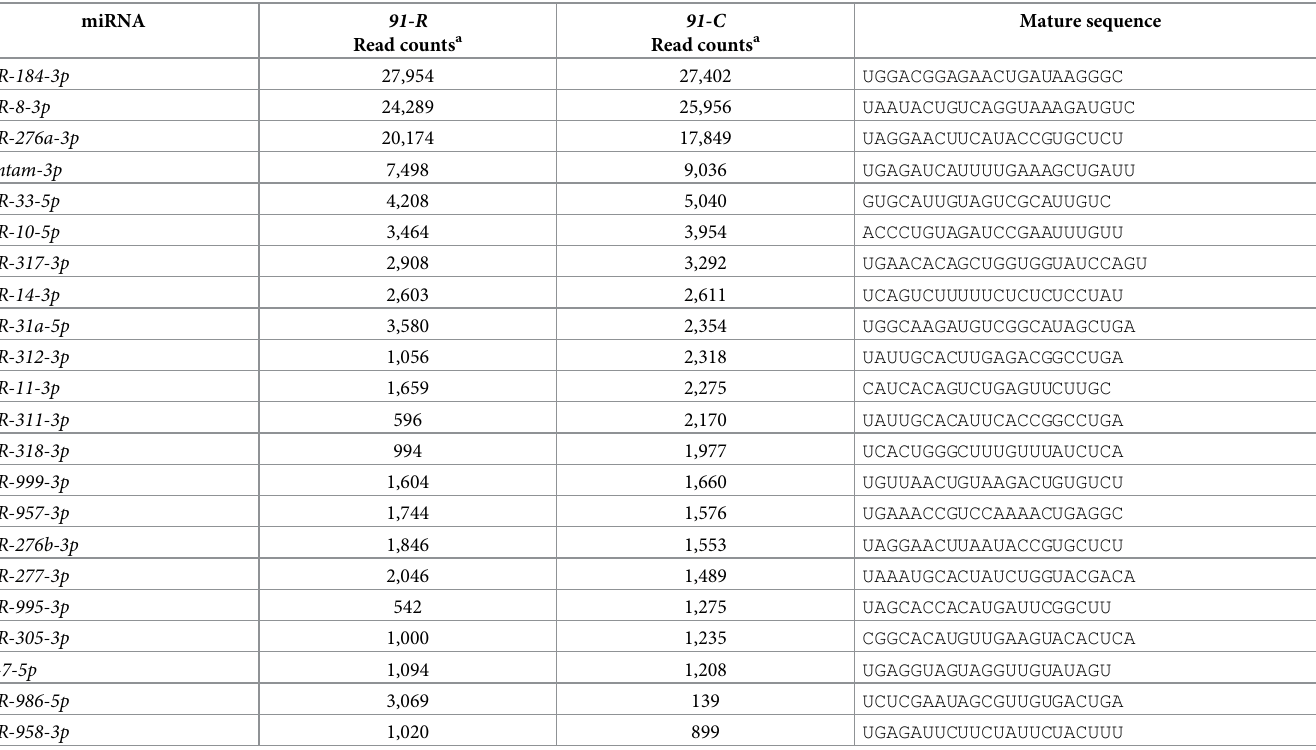
Table 2. The most abundant reads from 91-R and 91-C small RNA libraries corresponding to known Drosophilamelanogaster miRNAs in miRBase R.21. miRNA